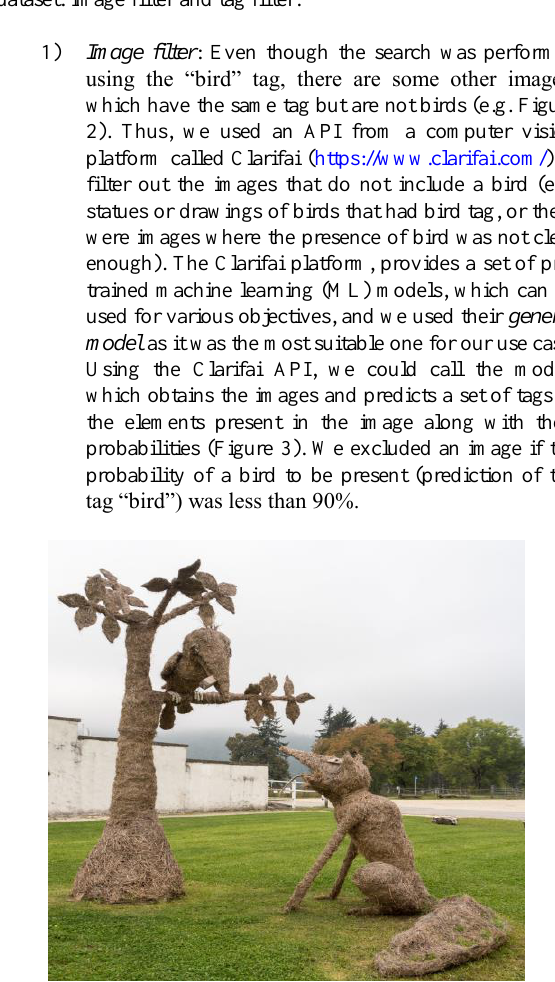
Figure 2: An example of an image with bird tag, which was filtered out using Clarifai (Flickr image source: (Jag9889,